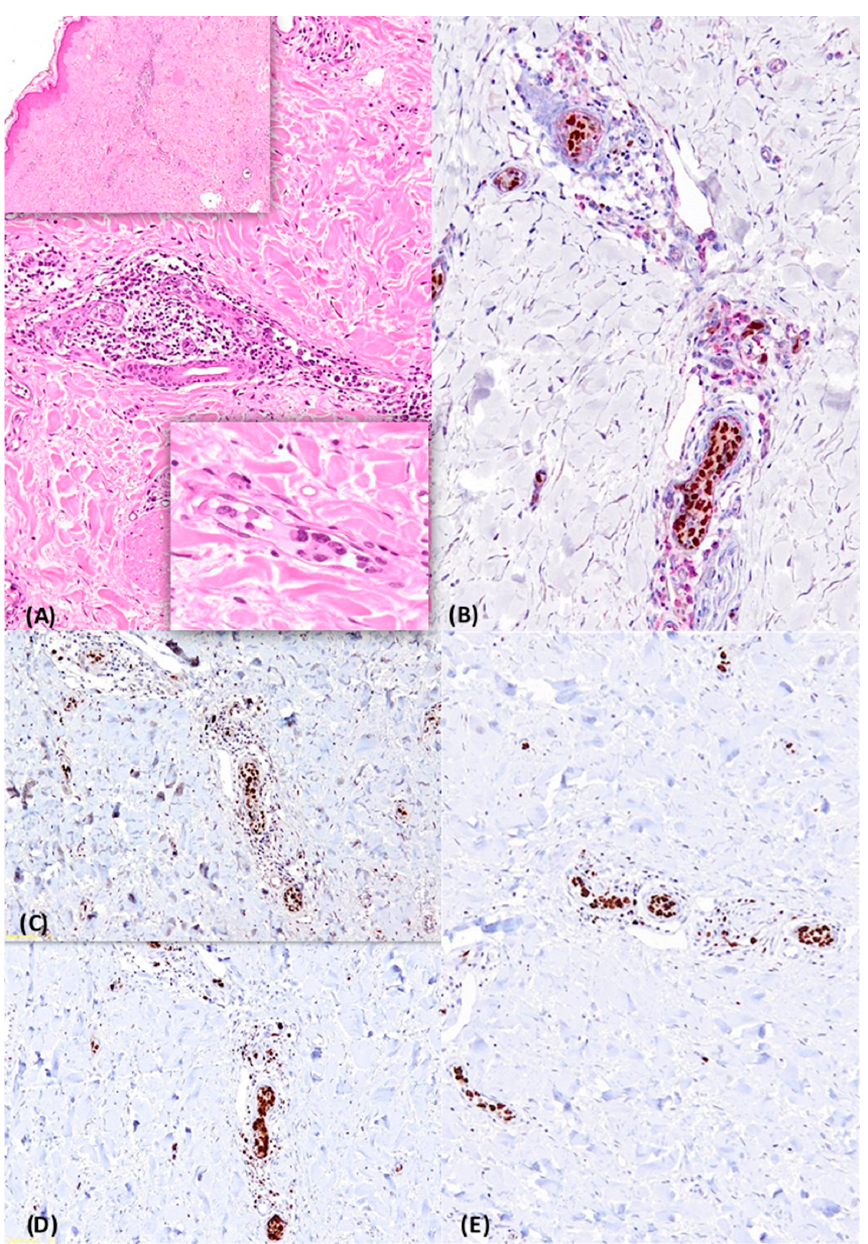
Figure 2. ( A ) H&E: the skin did not show significant cell infiltration in the dermis (inset; ×5), which could conversely be detected at a higher power (×20), being composed of large pleomorphic cells exclusively located within the vessel lumen (inset ×40). ( B ) CD31/PAX5: the double staining highlighted that the Pax5-positive neoplastic cells were only located within the lumen of blood vessels that were also stained positive for CD31 (×20). ( C ) Bcl6: nuclear staining for Bcl6 antigen at strong intensity (×20); confirmation of the purely intravascular infiltration of the neoplastic cells is also provided by this image. ( D ) IRF4: intense nuclear staining for MUM1/IRF4 antigen in the neoplastic cells; confirmation of the purely intravascular infiltration of the neoplastic cells is also provided by this image (×20). ( E ) Ki-67/MIB1: nuclear staining for Ki67 in most neoplastic cells; confirmation of the purely intravascular infiltration of the neoplastic cells is also provided by this image (×20).